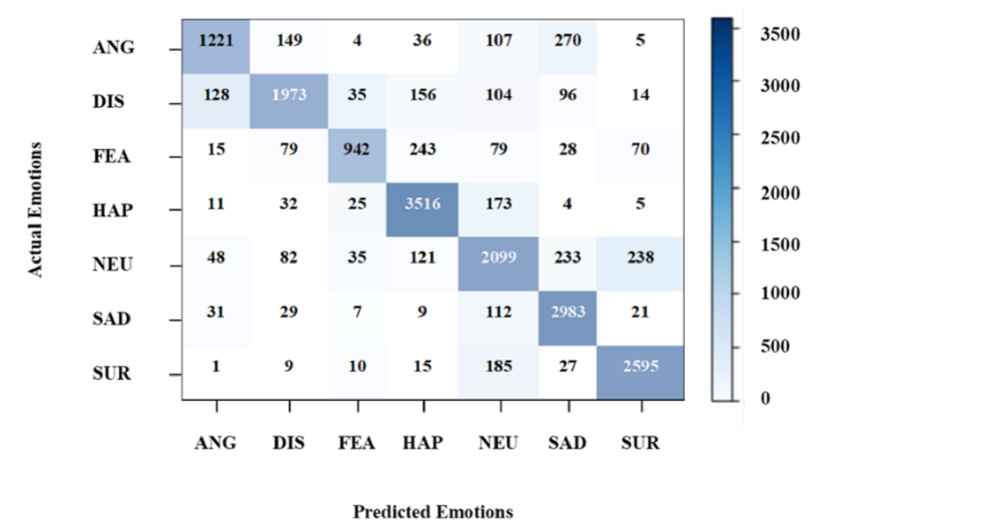
Figure 3. Confusion matrix of Test Model 1 after 10 epochs.